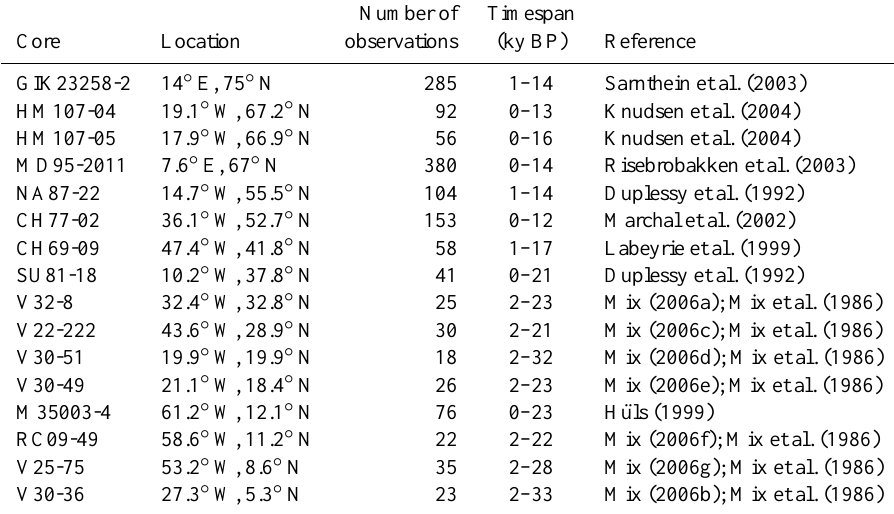
Table 1. Cores used in the